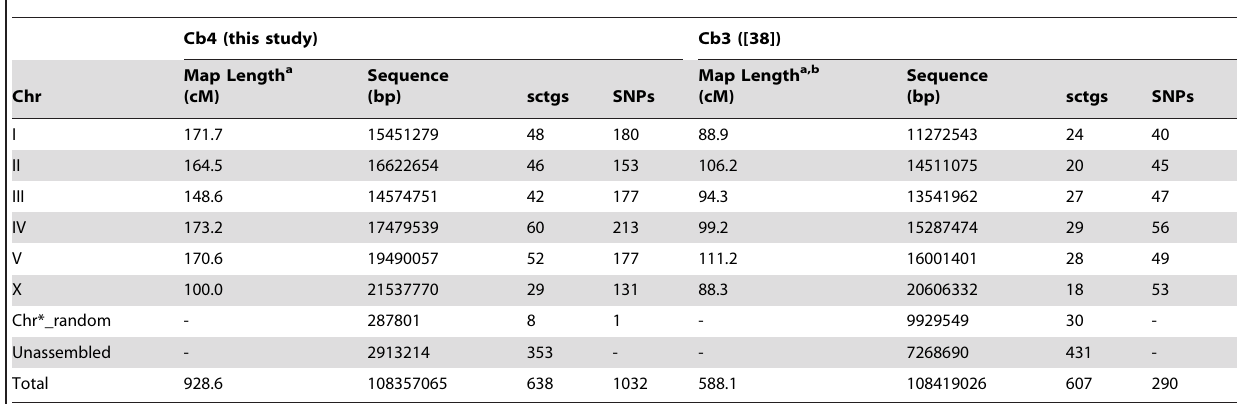
Table 1. Linkage map and genome assembly